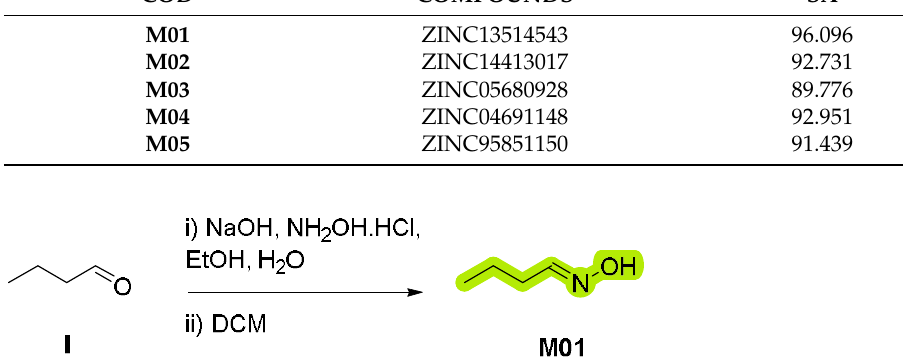
Table 5. Prediction of synthetic accessibility (SA).